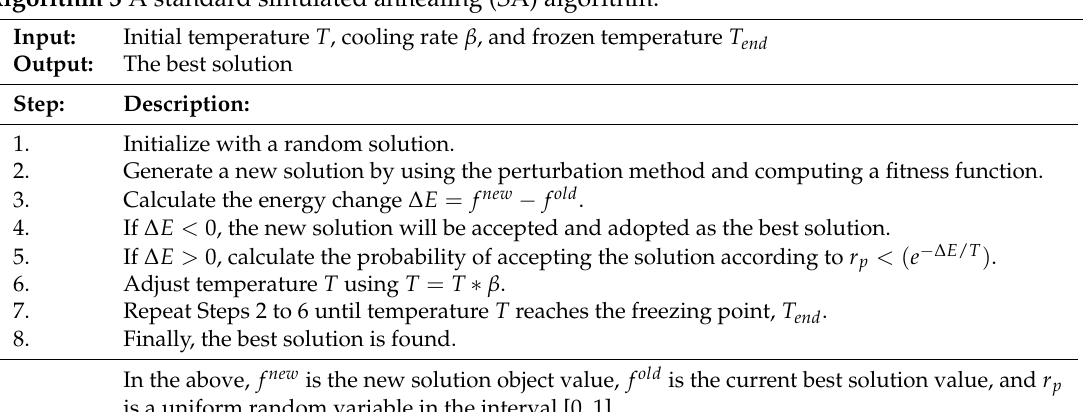
Algorithm 3 A standard simulated annealing (SA)